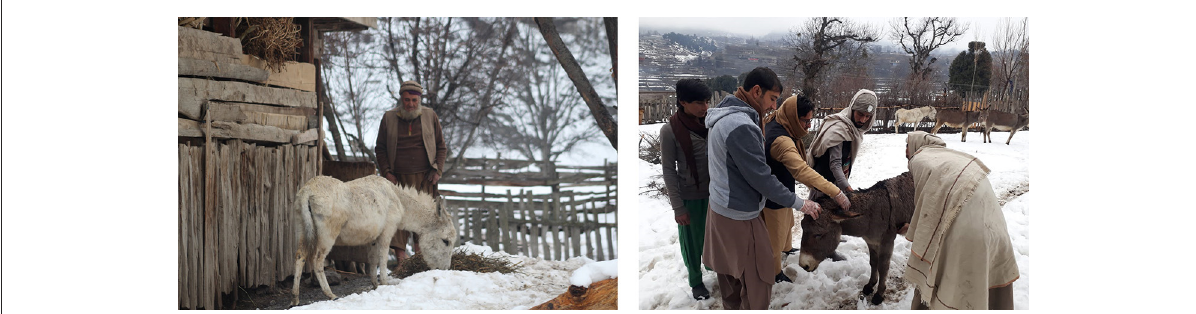
FIGURE3 (Left) The most observed lesions – back sore/bruises on the donkey: at the survey site, (Right) Donkeys for sale in the market; note that there is lack of shelter, water or feed (Photo credit: Kashif Kamran). Photo permission for inclusion was obtained from the people shown in the